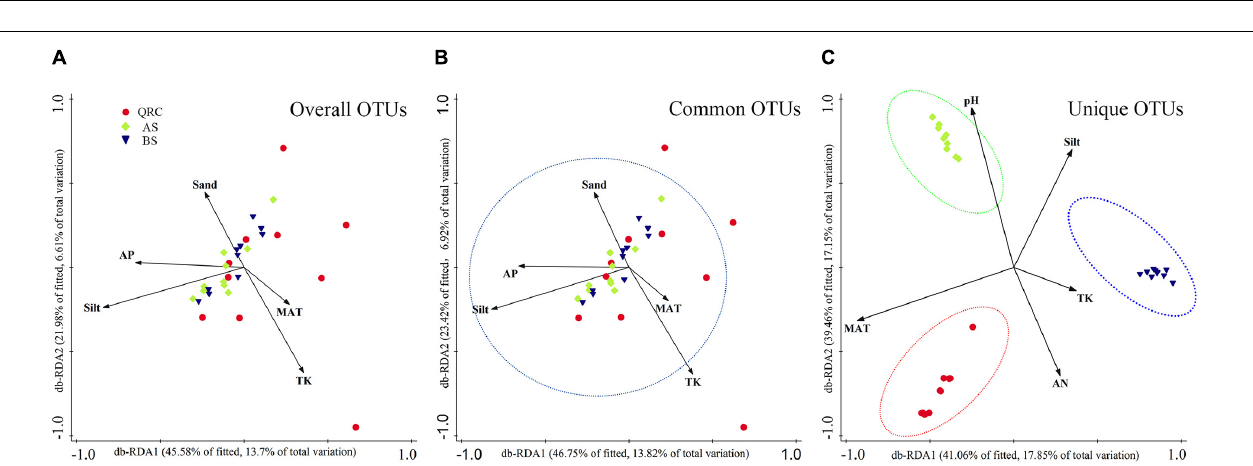
FIGURE 4 | Relationship between soil fungal nirK gene abundance and the contribution of fungi to N 2 O emission (A) , soil bacterial nirK gene abundance and the contribution of bacteria to N 2 O emission (B) , ratios of fungal/bacterial nirK abundance and the ratios of fungal/bacterial contributions to N 2 O emission (C) .